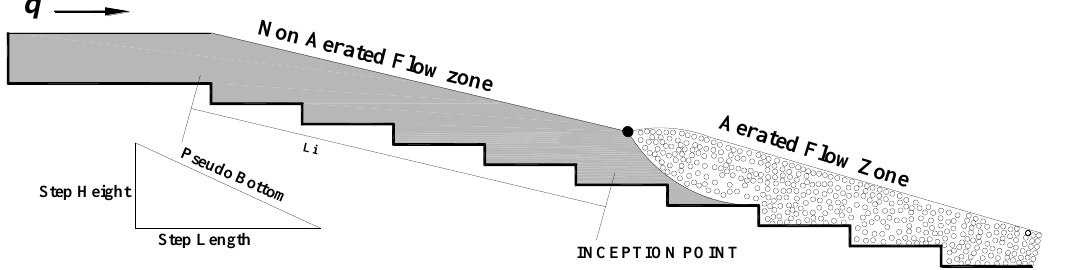
Figure 1. Schematic of inception point location in a stepped spillway during the skimming flow